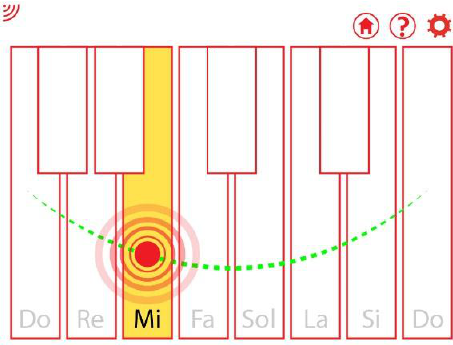
Figure 13. Example of the interaction produced in the game HybridEDU with the swing.